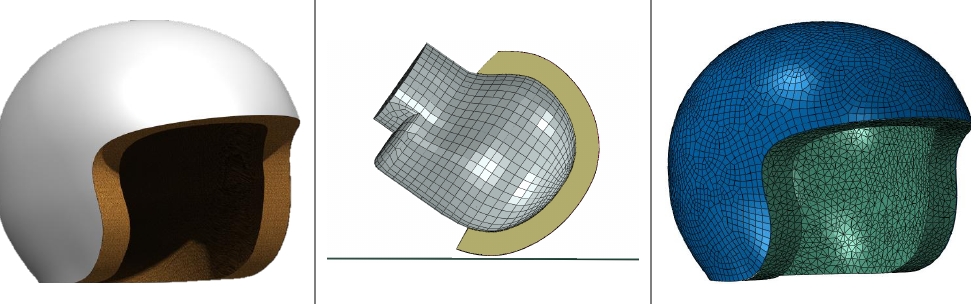
Figure 6. New jet helmet with constant thick liners: ( left ) render with 40 mm thick agglomerated cork liner; ( center ) Sagittal cut view of the FE model positioned for an impact at point B; ( right ) FE